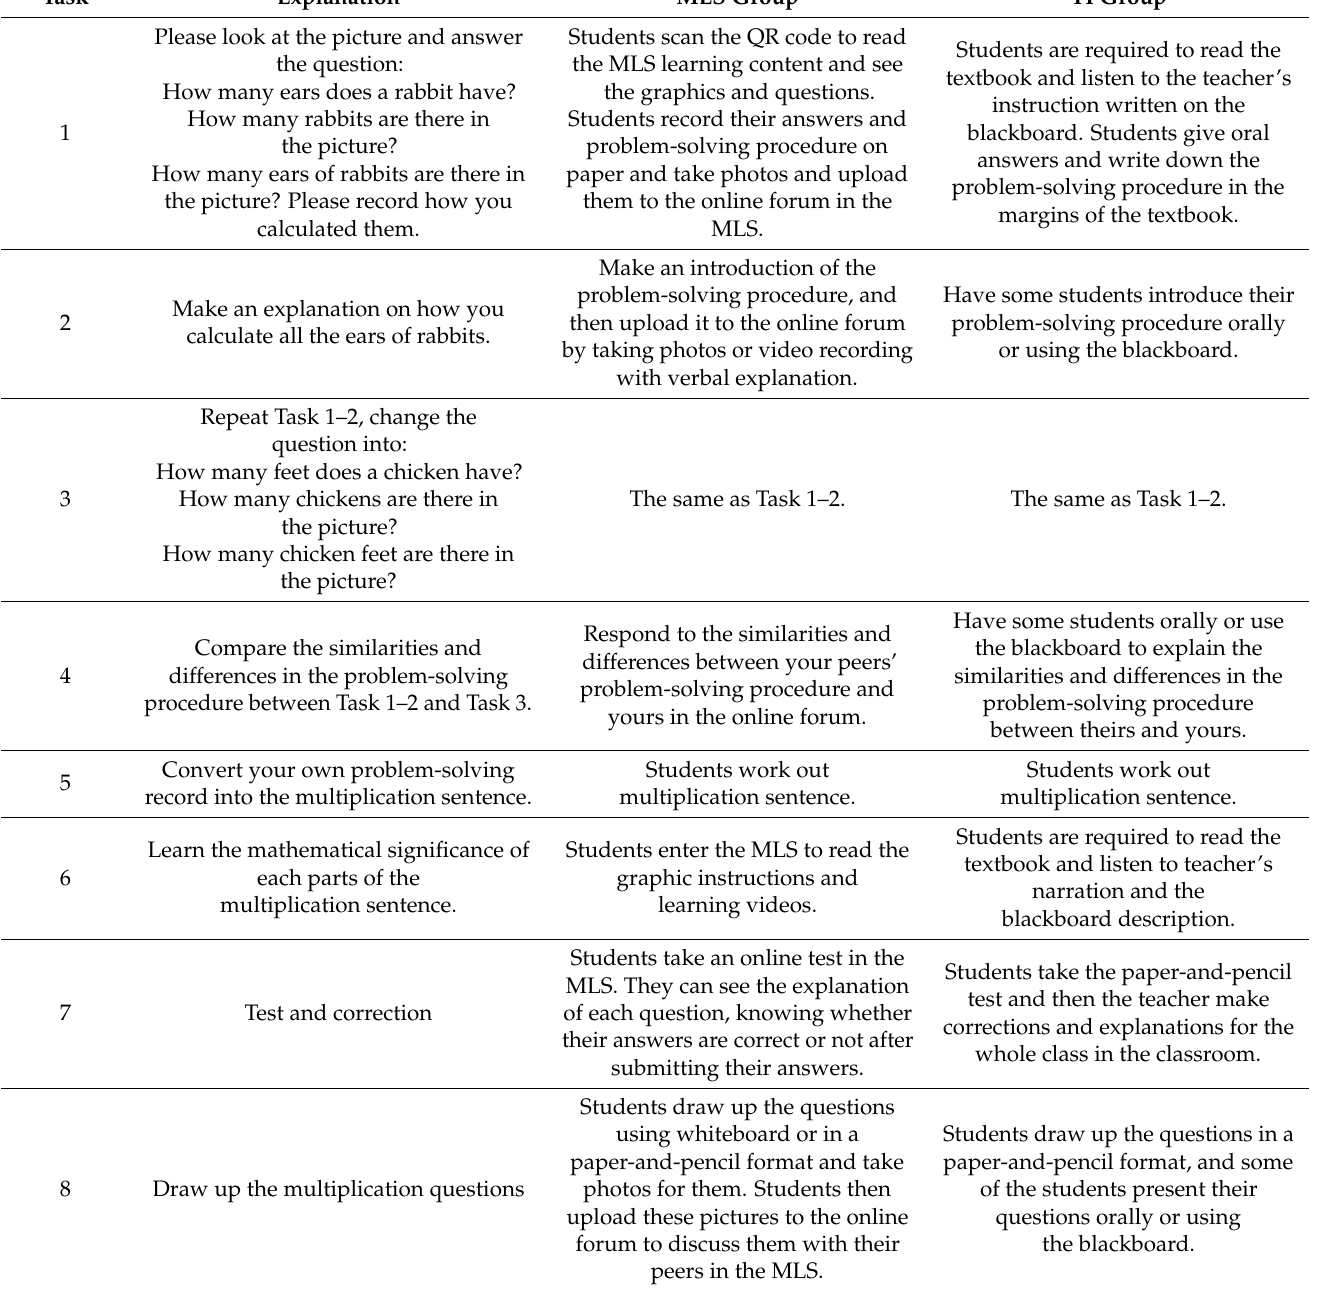
Table 1. A comparison of the procedure of learning activities in MLS group and TI group.